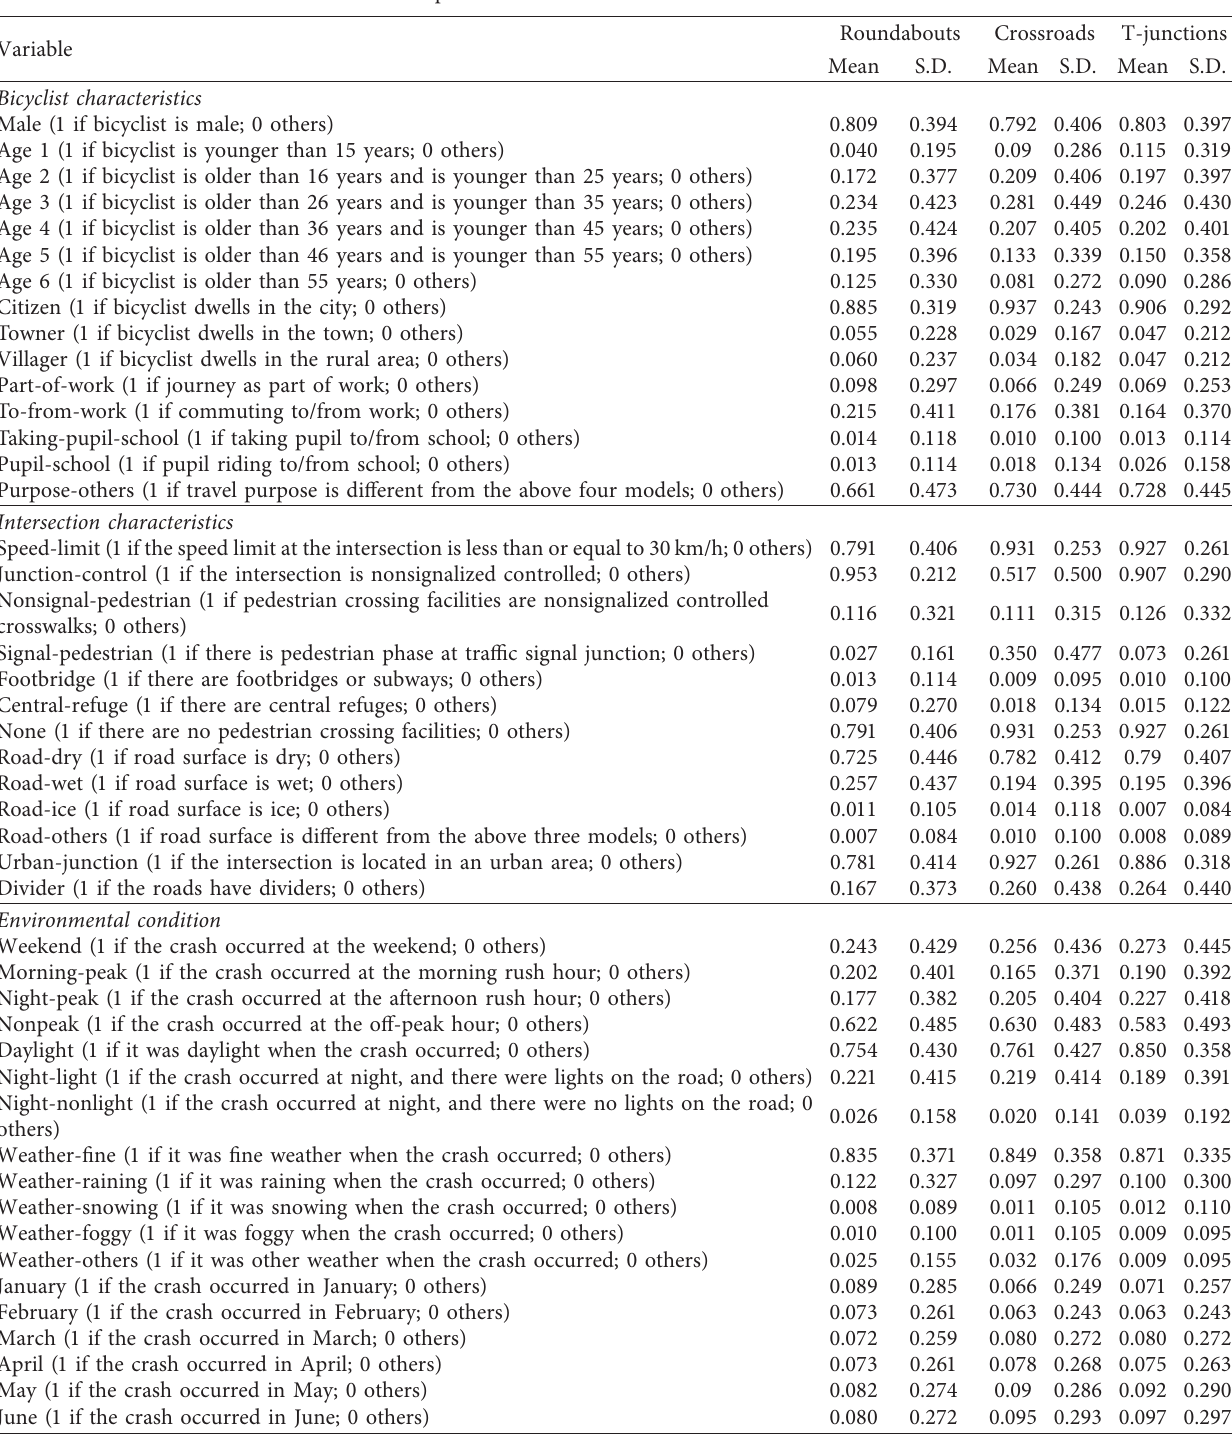
Table 2: Descriptive statistics of the variables used in the